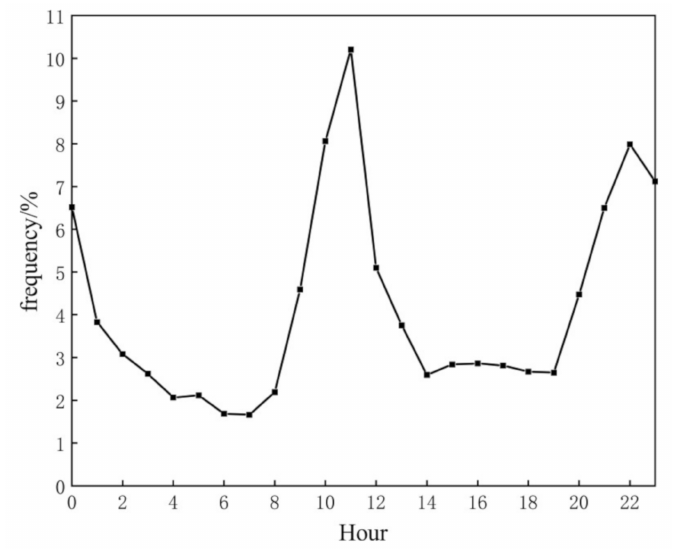
Figure 6. Frequencies of the starting time of dust events in the representative cities from 2015 to